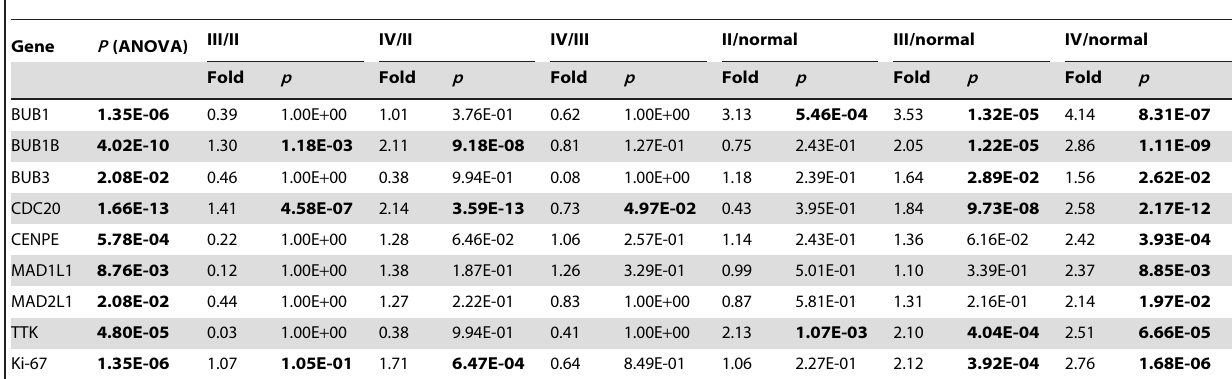
Table 3. Validation of the mitotic checkpoint genes in glioma tumors by qPCR.